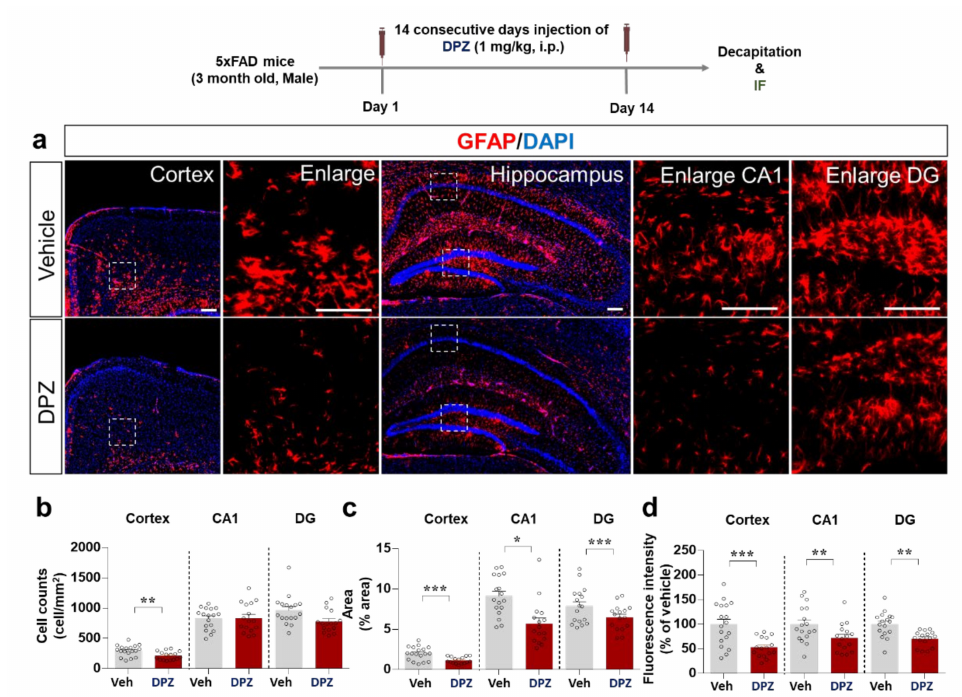
Figure 9. Donepezil attenuates A β -mediated astrogliosis and hypertrophy in 5xFAD mice. ( a ) Im- munostaining of brain sections from 5xFAD mice treated as shown with anti-GFAP. ( b – d ) Quantification of the results in ( a ) ( n = 16–18 brain slices from 4 mice/group). * p < 0.05, ** p < 0.01, *** p <